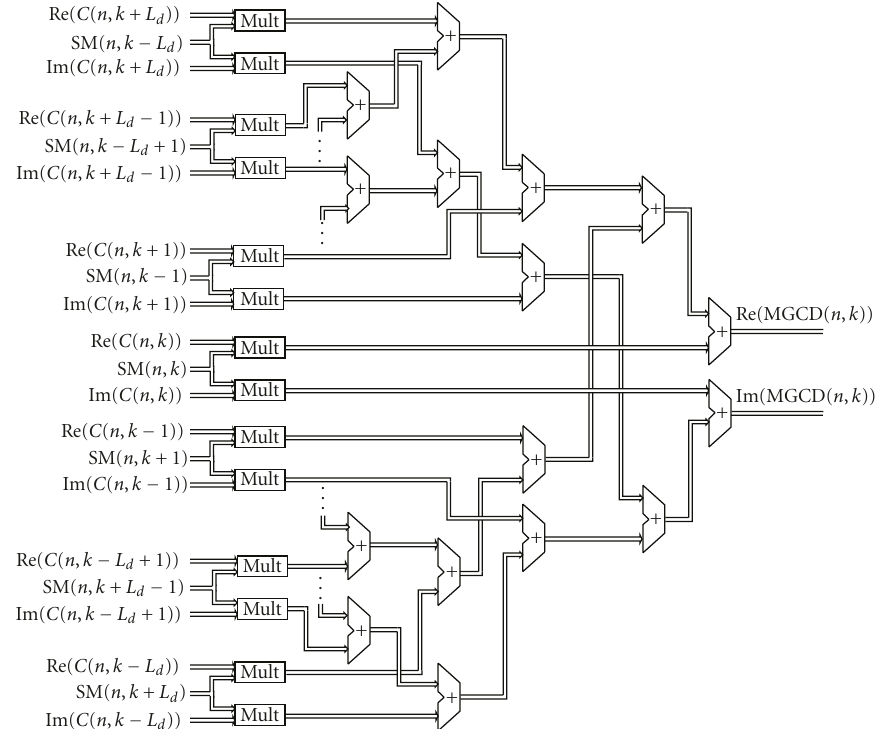
Figure 9: Architecture for realization of convolution between SM( n , k ) and C ( n , k ).